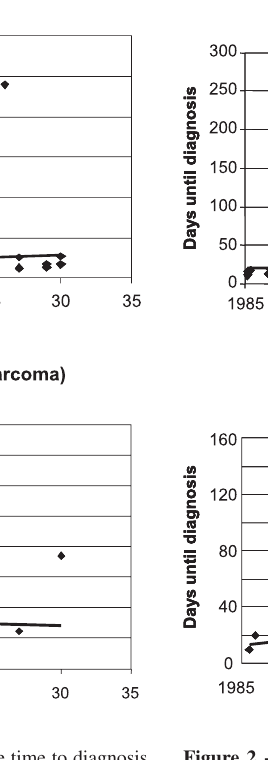
Figure 1 - Comparative analysis of patients’ age and the time to diagnosis of patients with Osteosarcoma and Ewing´s Sarcoma. Comparison using a two-tailed Mann-Whitney U-test (±=0.05) Table 1 - Descriptive statistics of patients’ age and time to diagnosis in the Osteosarcoma and Ewing’s Sarcoma groups. Comparison using a two-tailed Mann-Whitney u-test (±=0.05)